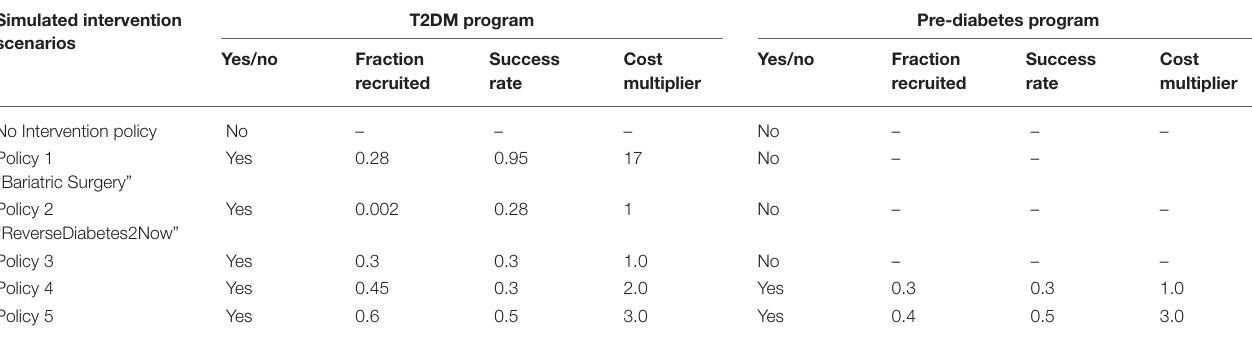
TABLE 2 | Hypothesized intervention scenarios and their parameter values used in scenario simulation. Simulated intervention T2DM program scenarios Yes/no